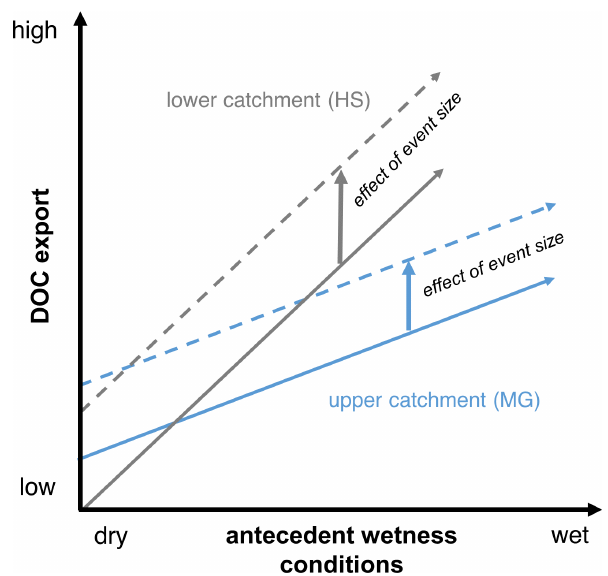
Figure 7. Conceptual figure of the relation between event size, an- tecedent conditions and DOC export for the upper catchment MG (blue lines) and the lower catchment HS (gray lines). During simi- larly sized events (June 2018, October 2018 and May 2019), DOC export increased with the antecedent wetness in both subcatchments (solid lines), whereby the relation was more pronounced in the lower catchment. Therefore, the upper catchment contributed pro- portionally more to the total DOC export during events following dry antecedent conditions due to the low hydrological connectivity in the lower catchment. With increasing antecedent wetness, hy- drological connectivity was established in the lower catchment, and its relative contribution to DOC export exceeded the contribution of the upper catchment. Larger events (September 2020) led to a larger DOC export at both subcatchments (dashed